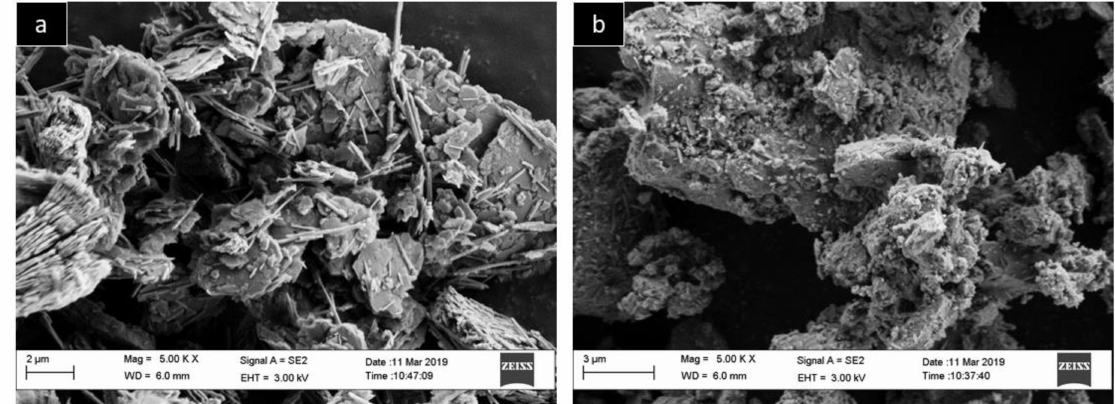
Figure 4. Microstructure of ( a ) kaolin and ( b ) ground granulated blast furnace slag.